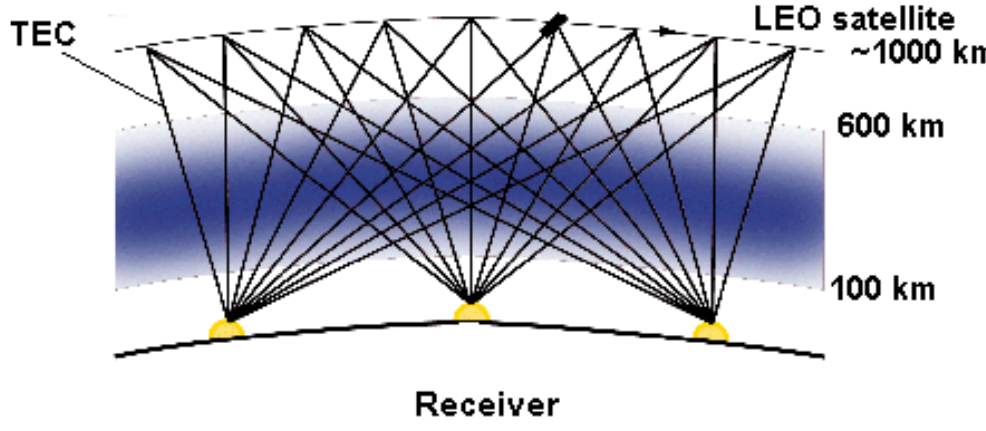
Fig. 1. The geometry for ionospheric tomographic imaging, showing the ray paths between a low orbiting satellite and ground receiving